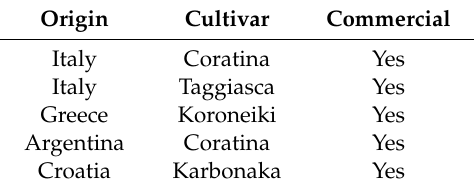
Table 4. O ff diagonal elements of the test confusion matrix reported in Table